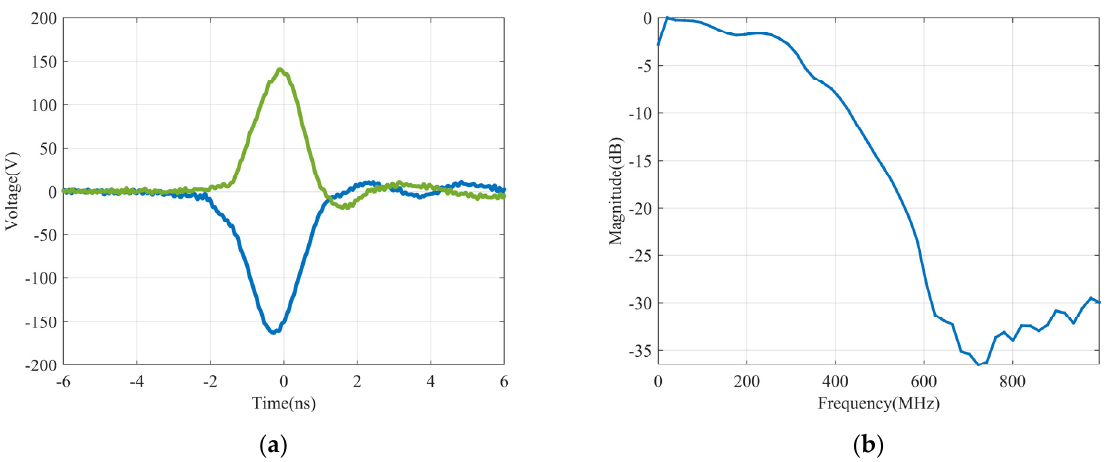
Figure 8. The output balanced pulses of the transmitter. ( a ) Measurement result in time domain, and ( b ) calculated power spectrum.